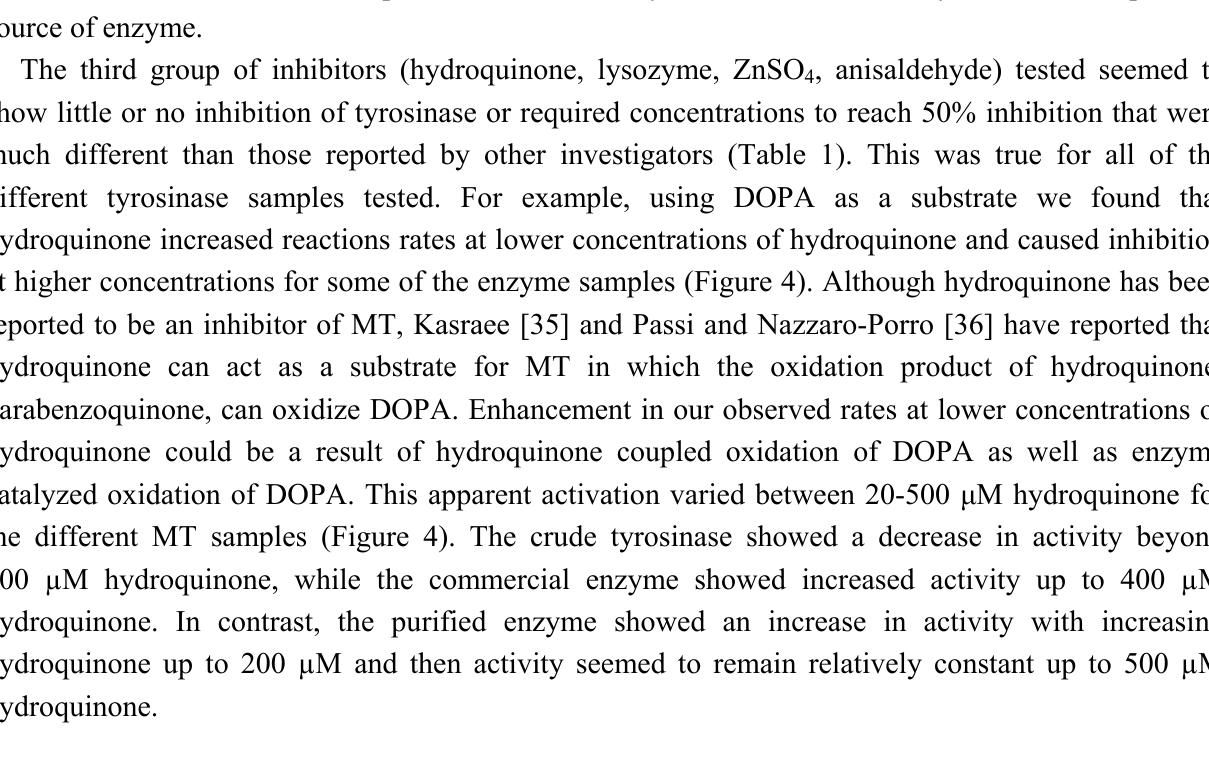
Figure 4. Inhibition of mushroom tyrosinase by hydroquinone. Assays were carried out as described in the Experimental